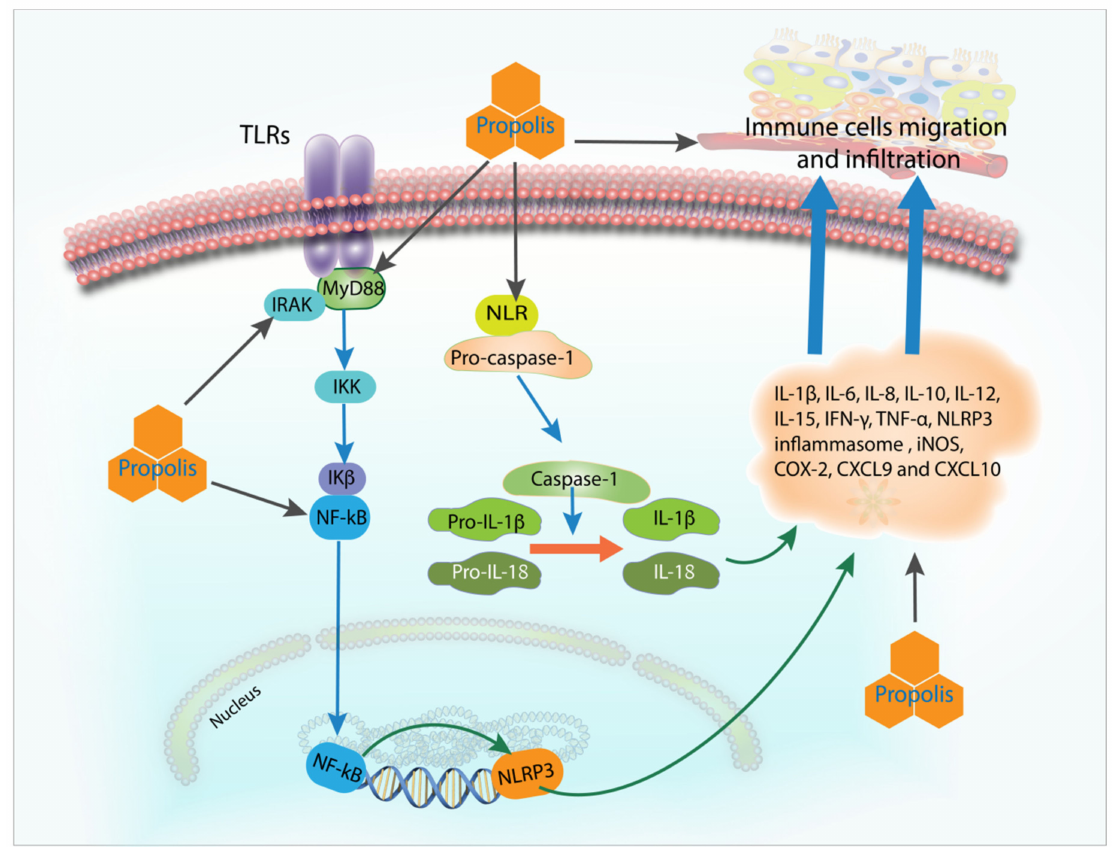
Figure 2. Various mechanisms of action of propolis in modulating inflammation towards the regula- tory balance. This figure is constructed based on the biochemical and molecular markers investigated in the 166 included papers. Propolis appears to inhibit and downregulate TLR4, MyD88, IRAK4, TRIF, and NLRP inflammasomes, and their associated pro-inflammatory cytokines such as IL-1 β , IL-6, IFN- γ , and TNF- α . Propolis also decreases the migration of immune cells such as macrophages and neutrophils, possibly by downregulating chemokines CXCL9 and